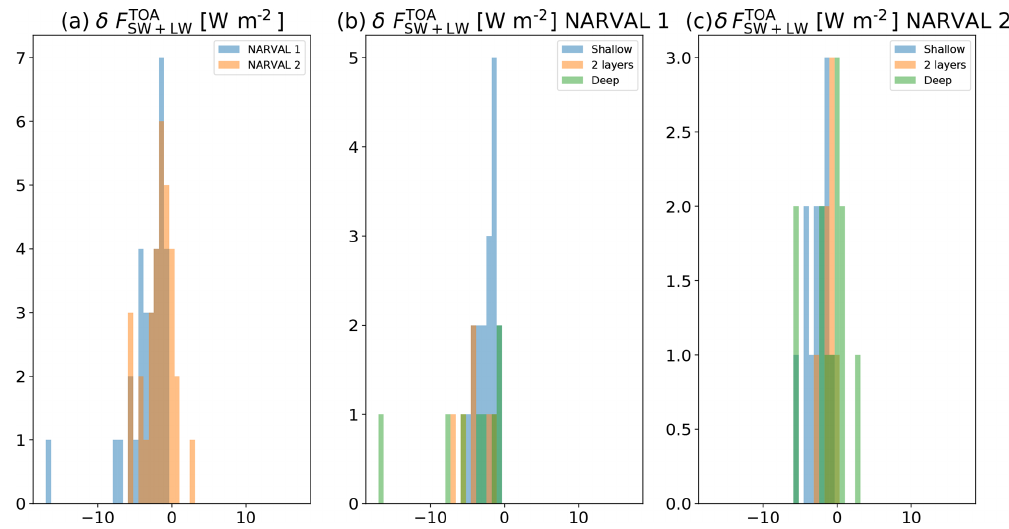
Figure 10. Histograms of the response of the net (shortwave + longwave) top-of-atmosphere radiative flux (F TOA bation (polluted simulations minus clean simulations) for each of the simulated days. In (a) blue represents the NARVAL 1 month (December 2013), while orange the NARVAL 2 month (August 2016). In (b) and (c) the NARVAL 1 and the NARVAL 2 months are separated into the different cloud regimes: shallow clouds (blue), two-layer clouds (shallow clouds with cirrus clouds layer above – orange), and deep clouds